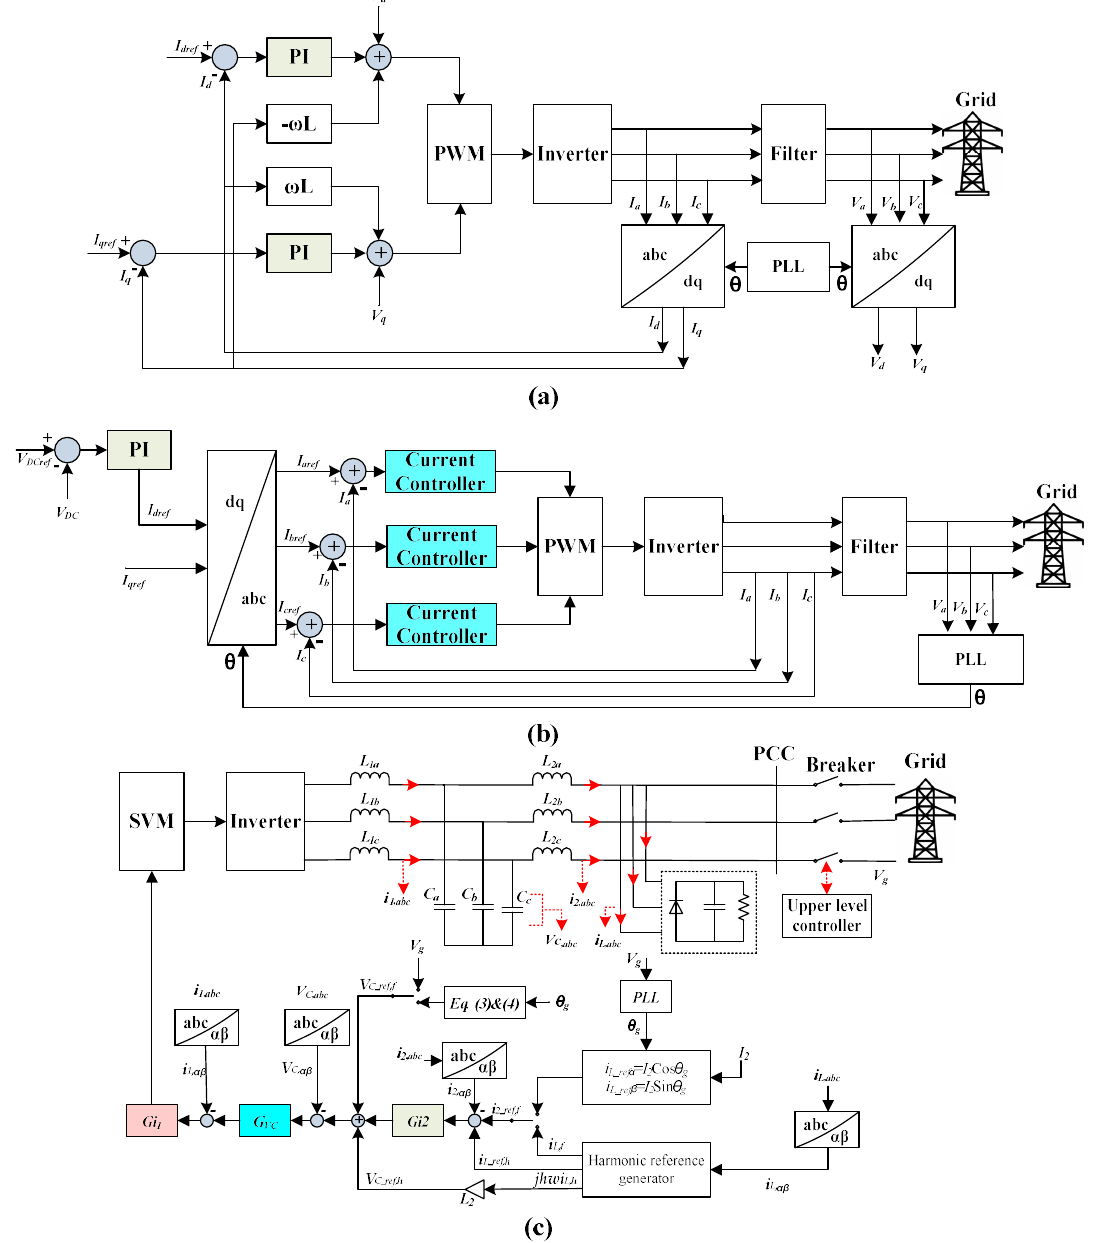
Figure 9. Generalized reference frame configuration of ( a ) dq , ( b ) abc , and ( c ) αβ.